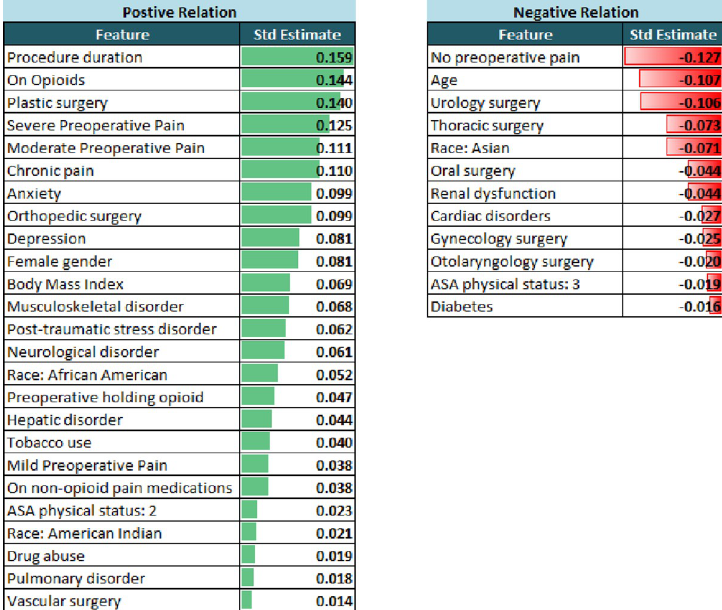
Fig 3. Bivariate relationships between preoperative features and postoperative MME opioid requirements are shown. Only statistically significant (p < 0.05) relations are shown with standard estimate (Std Estimate) representing the strength of the relationship. The positive and negative relations are show in green and red colors